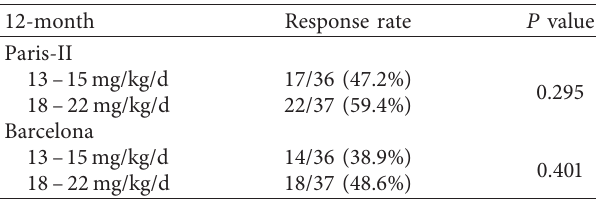
Table 3: Response by definition of Barcelona and Paris-II criteria at 12